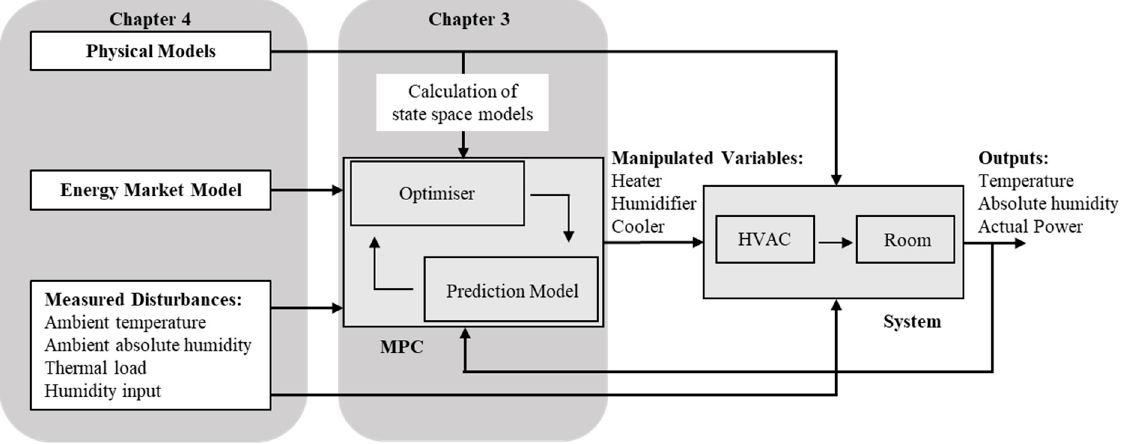
Figure 1. Schematic structure of the model predictive control system.